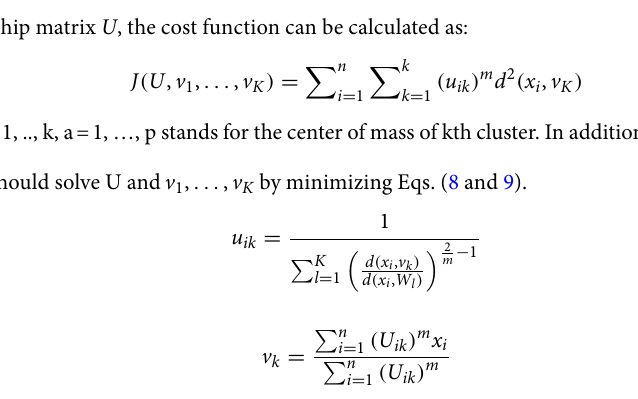
Minimizing task is carried out by the following cost function.